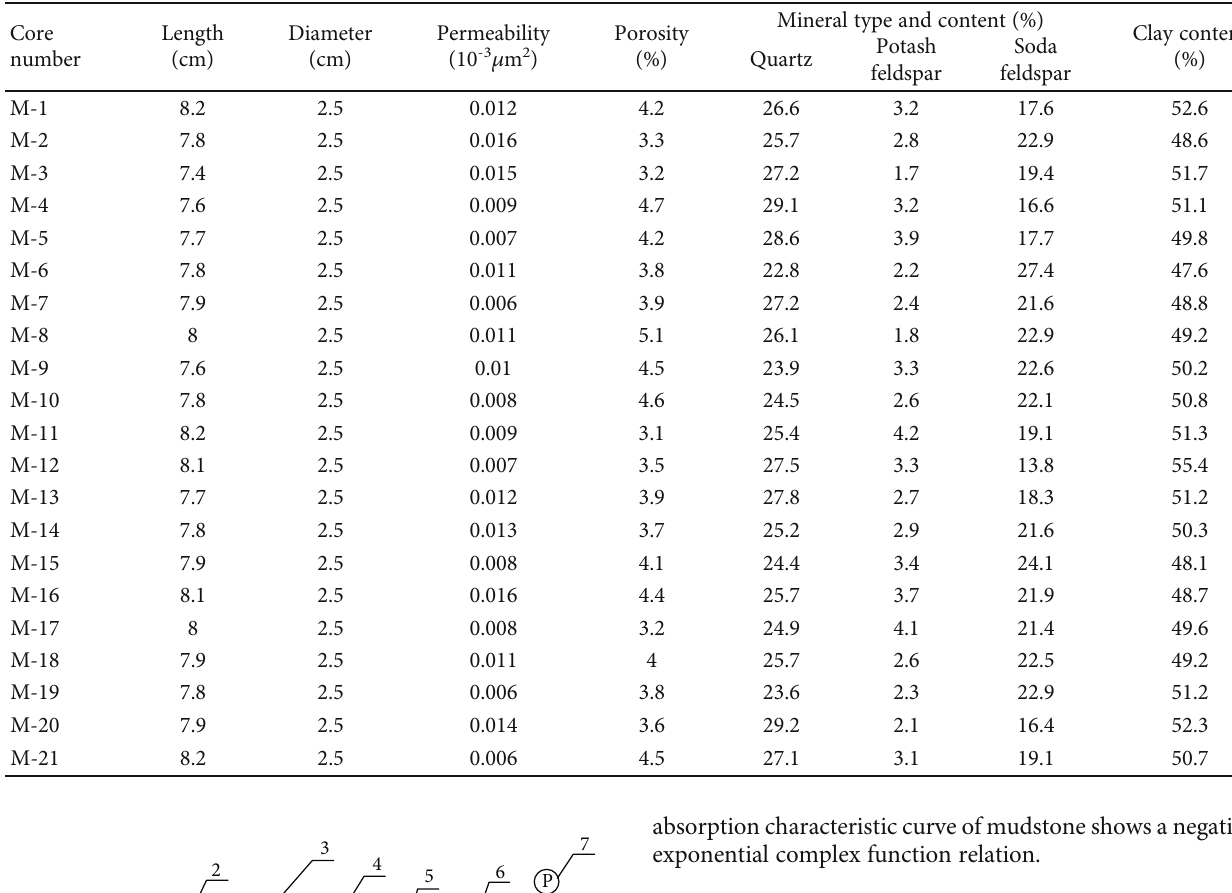
Table 1: Basic parameters and compositions of core samples from the inspection wells.